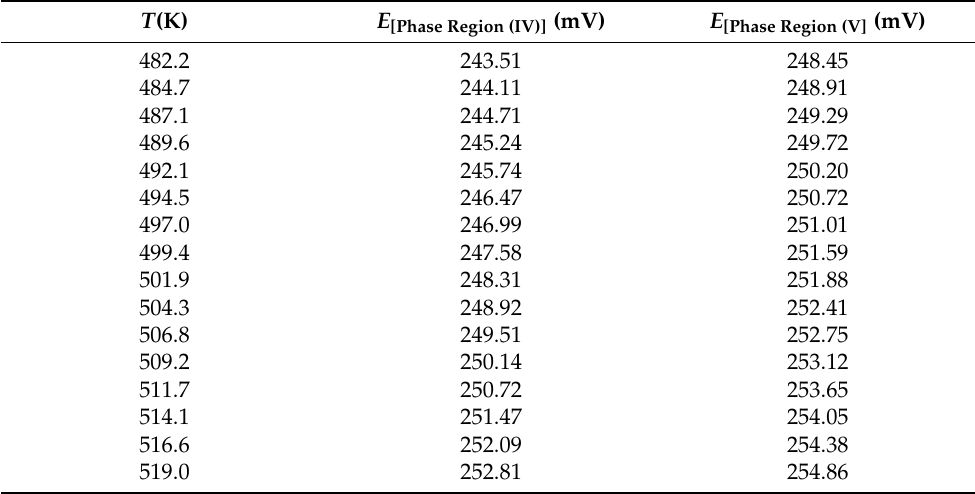
Table 5. A summary of the measured temperatures and EMF values of the ECCs in different phase regions of the Fe–Te–Ag